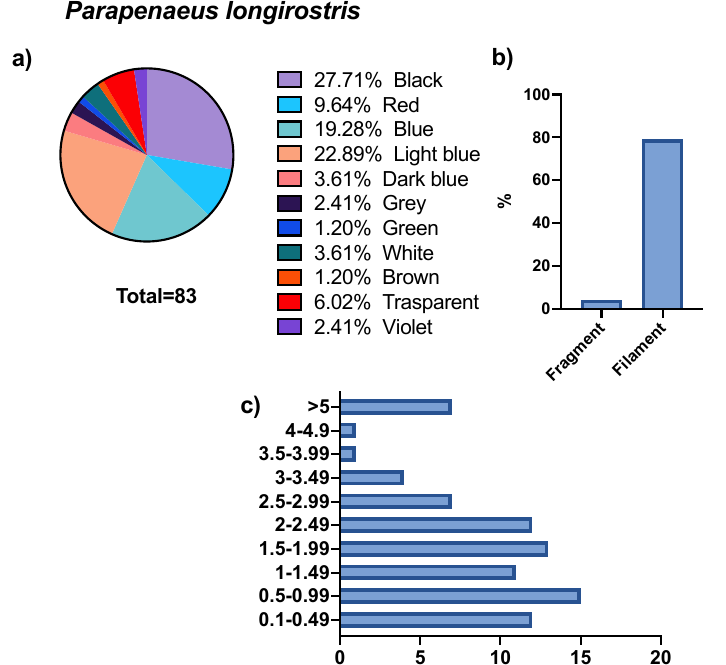
Figure 2. Abundance, colors ( a ), shape ( b ), and size ( c ) of microparticles isolated from P. longirostris specimens.